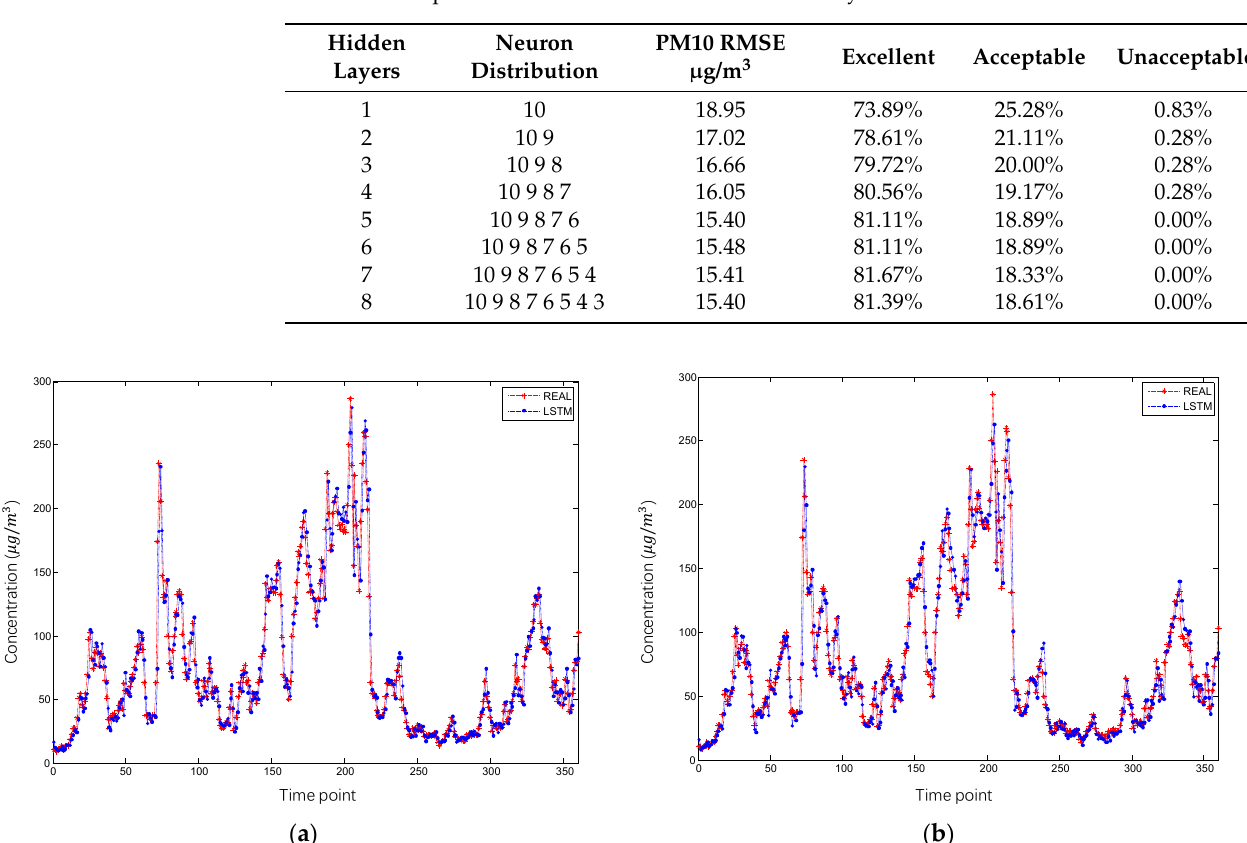
Figure 5. Prediction results of PM10 in different hidden layers of the LSTM model: ( a ) five hidden layers; ( b ) seven hidden layers.